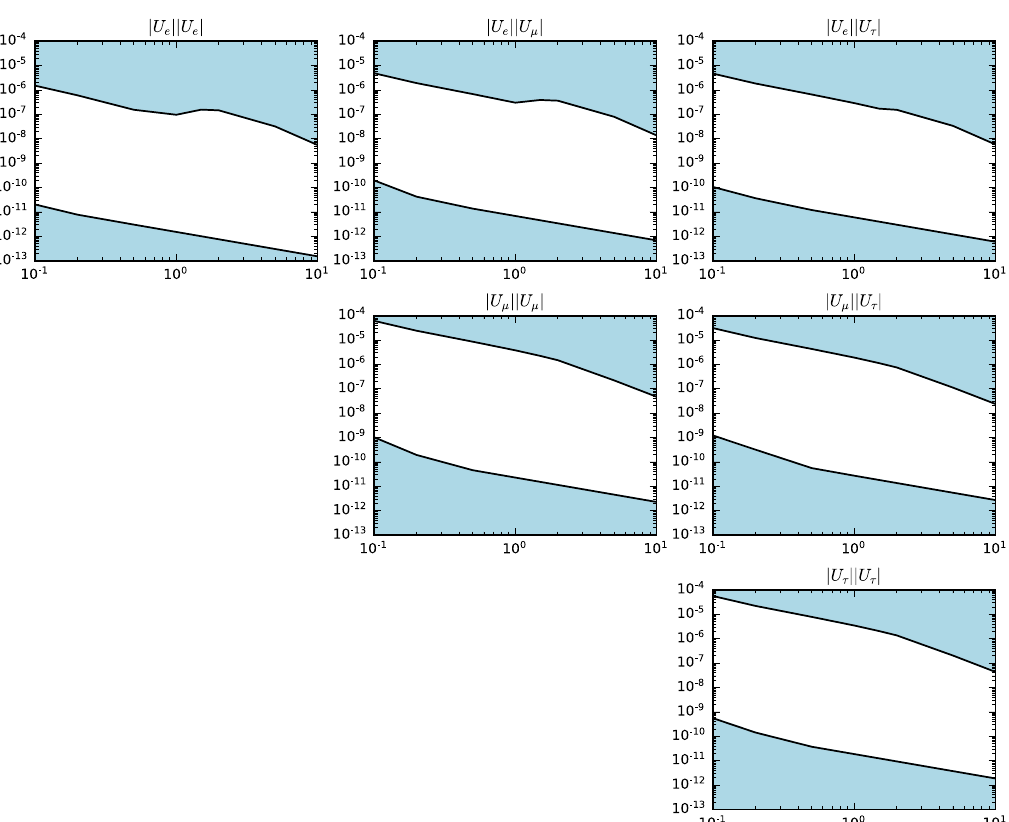
2 and products . U α U α U β | | | |·| |